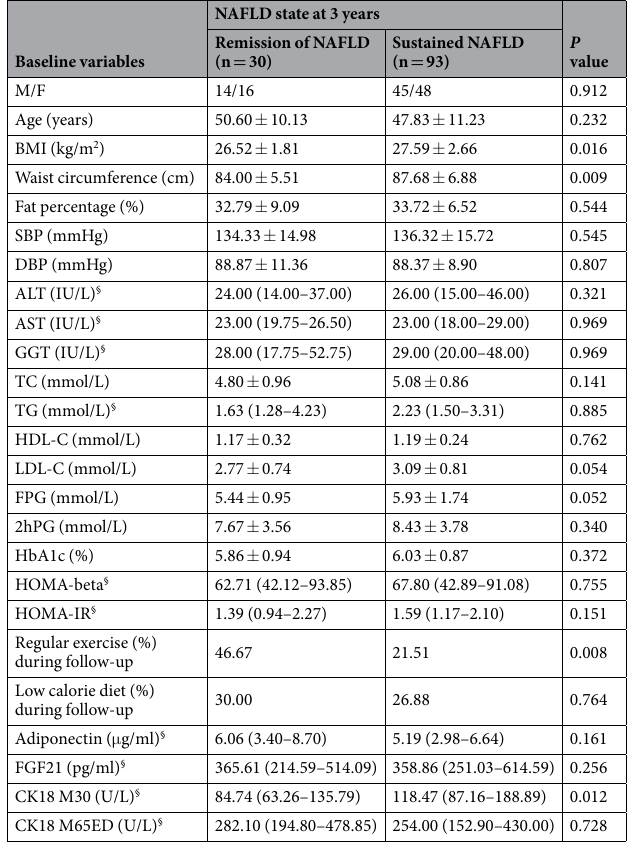
Table 3. Baseline clinical parameters of 123 subjects who had remission of NAFLD or sustained NAFLD after 3-year follow-up. Data are means ± SD or median (interquartile range). § Ln transformed before